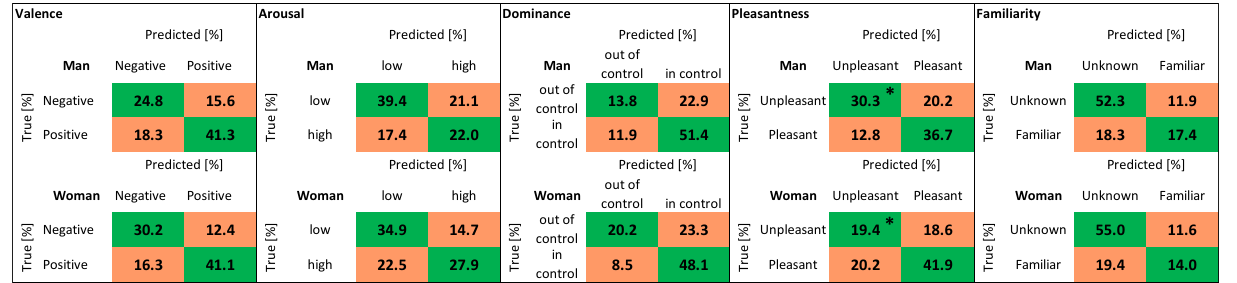
Figure 13. Analysis of six PRV features. Values distributed into the two classes: Man, Woman. Un- paired t -test, two-tailed. The means are significantly different in four cases: SDNN, HF, LF, and SD2. In Figure 14, there are some more details about the classification results. The 238 observations were divided into two groups: 109 belong to men, 129 to women. The confusion matrices show the results of classification using: the KNN algorithm, PRV + SP features, and LOSO cross-validation. There is only one statistically significant difference between the results for men and women: the classification of pleasantness (“unpleasant” class).